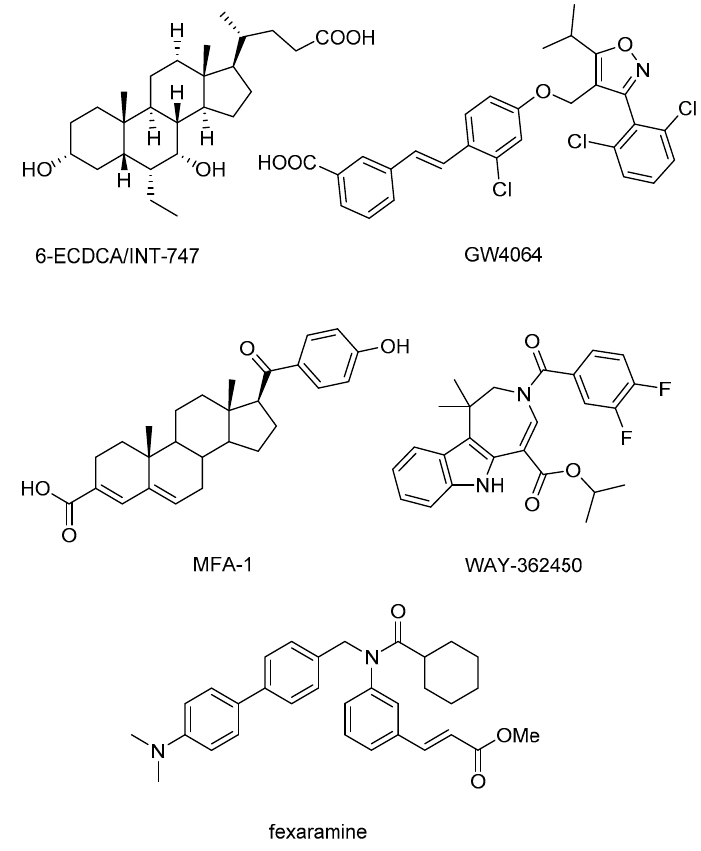
Figure 1. Structures of some farnesoid X receptor (FXR) agonists.